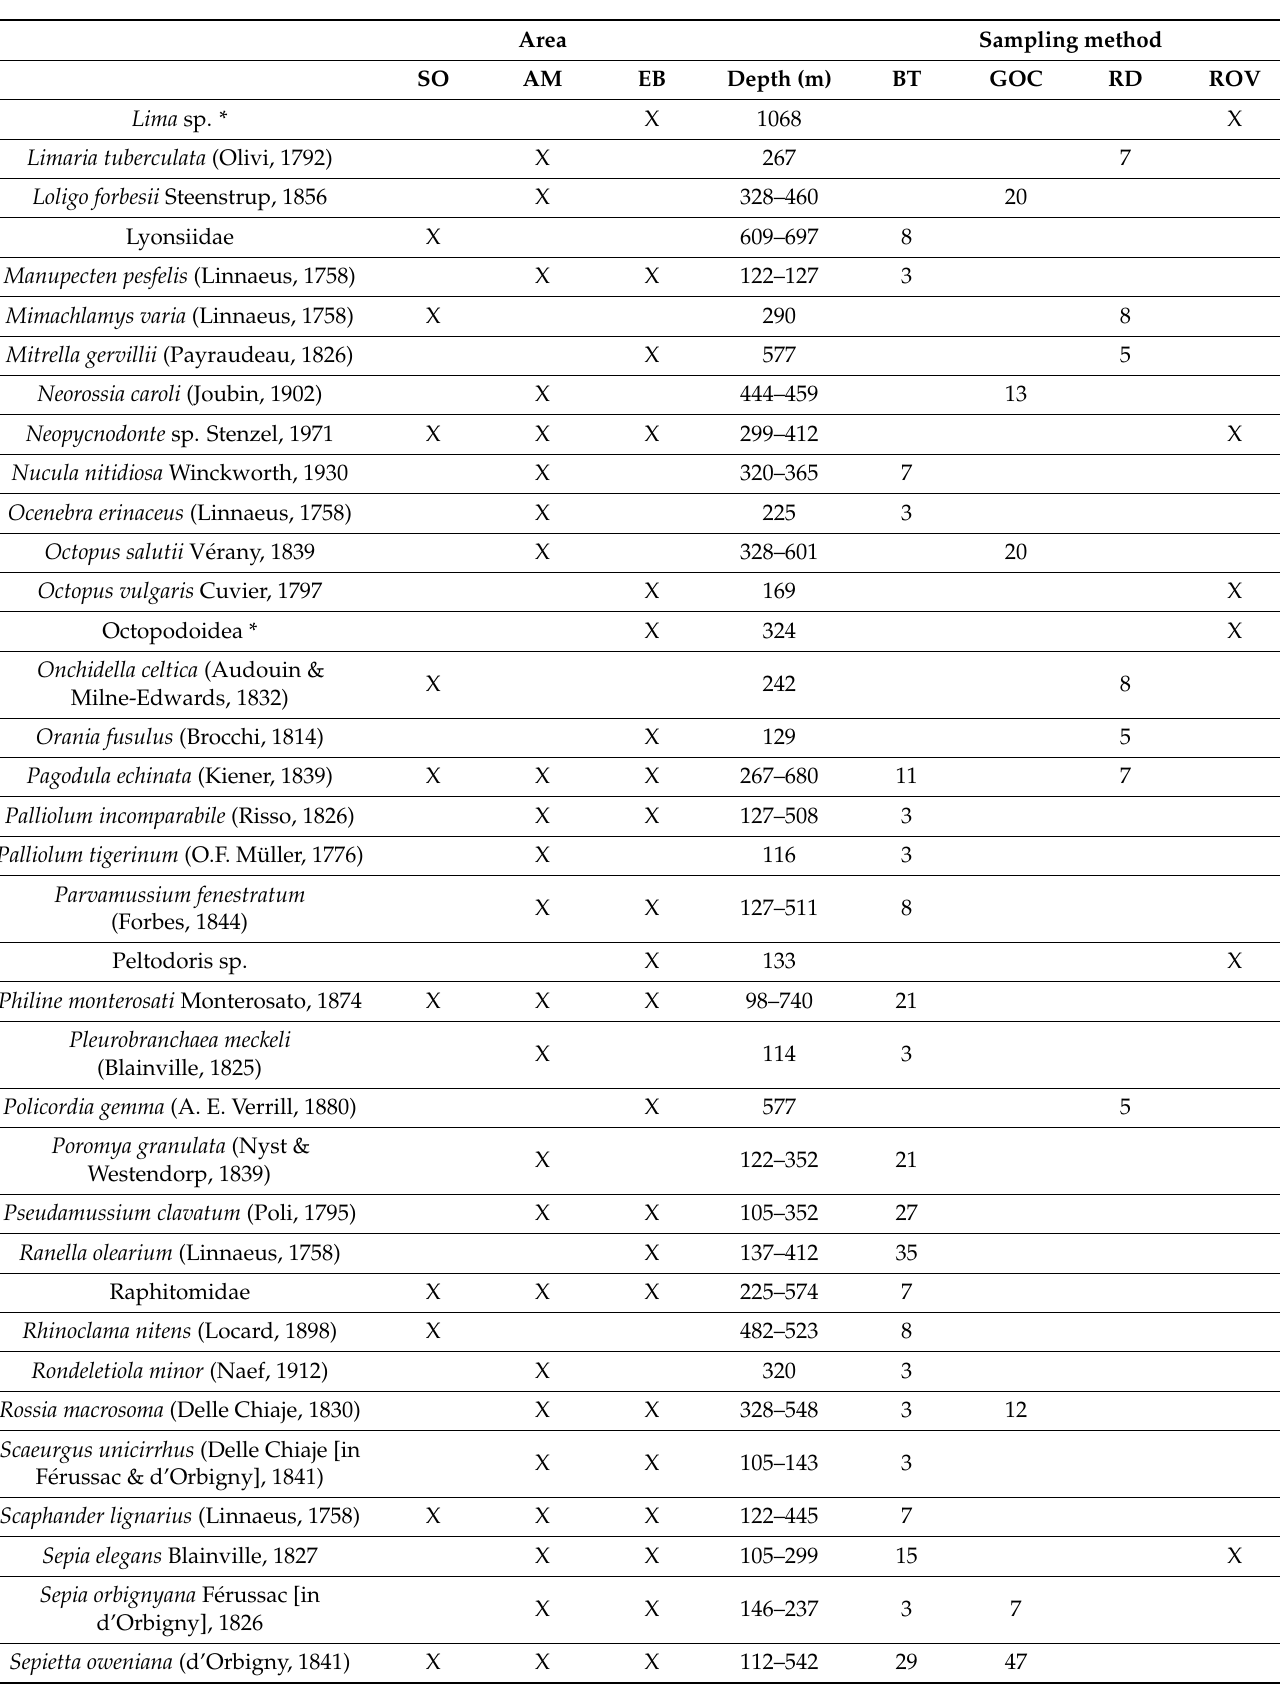
Table A7. Cont. Area Sampling